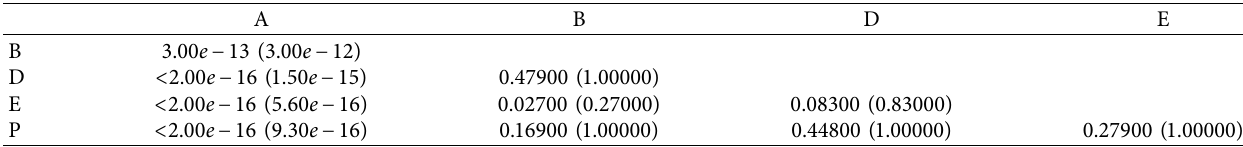
Table 16: In L-Space, for Thunder Bay Transit network, pI � 0.05, pR � 0.0025, and T � 65, p -value of the Wilcoxon rank sum test (resultant p -value per Bonferroni correction is indicated in brackets).